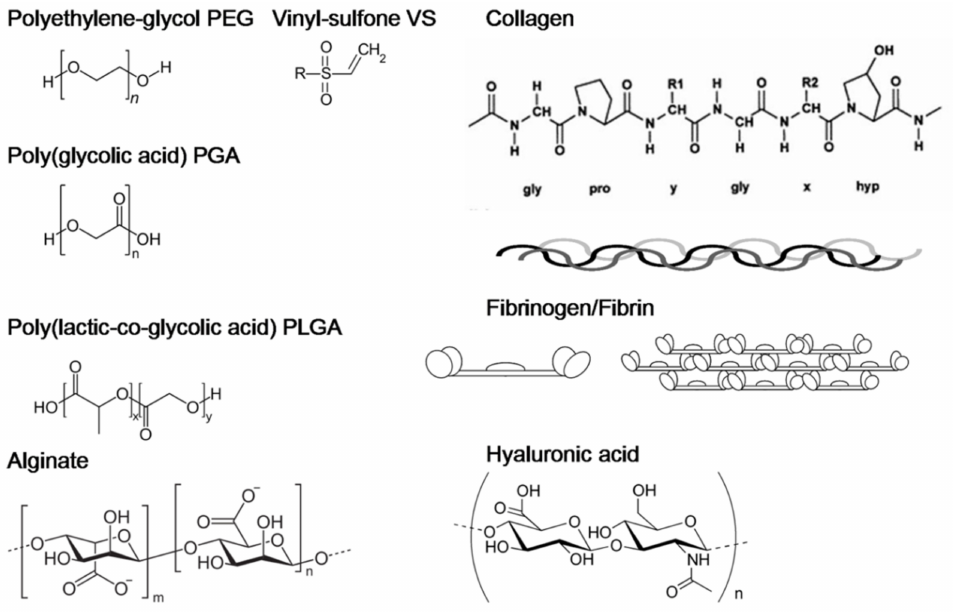
Figure 1. Schematic representation of polymers used to create scaffolds used in vivo for female genital tissue engineering. Vinyl-sulfone can combine in several occurrences with PEG. Polyglycolic acid and PLGA can be combined to support growth of cells during their biodegradation. These synthetic biopolymers rely on hydrophilic interaction for cell adhesion and may be crosslinked to various degrees to control substrate stiffness. Alginate can be combined with other material to serve as a support while being relatively inert in terms of biological function. Collagen and its